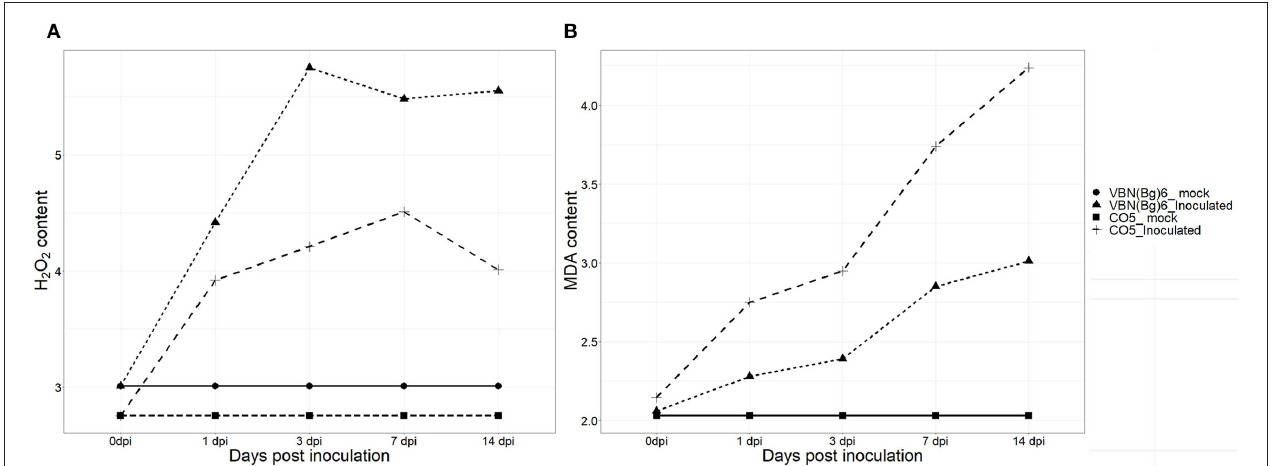
FIGURE 1 | The changes of H 2 O 2 ( µ mol g − 1 FW) (A) and MDA ( µ mol g − 1 FW) (B) concentrations in two blackgram cultivars VBN (Bg) 6 and CO 5 after urdbean leaf crinkle virus